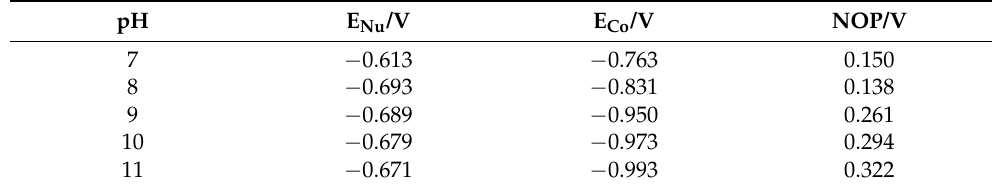
Figure 5. Cyclic voltammograms of Co-Mo electrodeposition in electrolytes with different pH values. Table 4. The kinetic parameters for Co-Mo electrodeposition with different pH values.